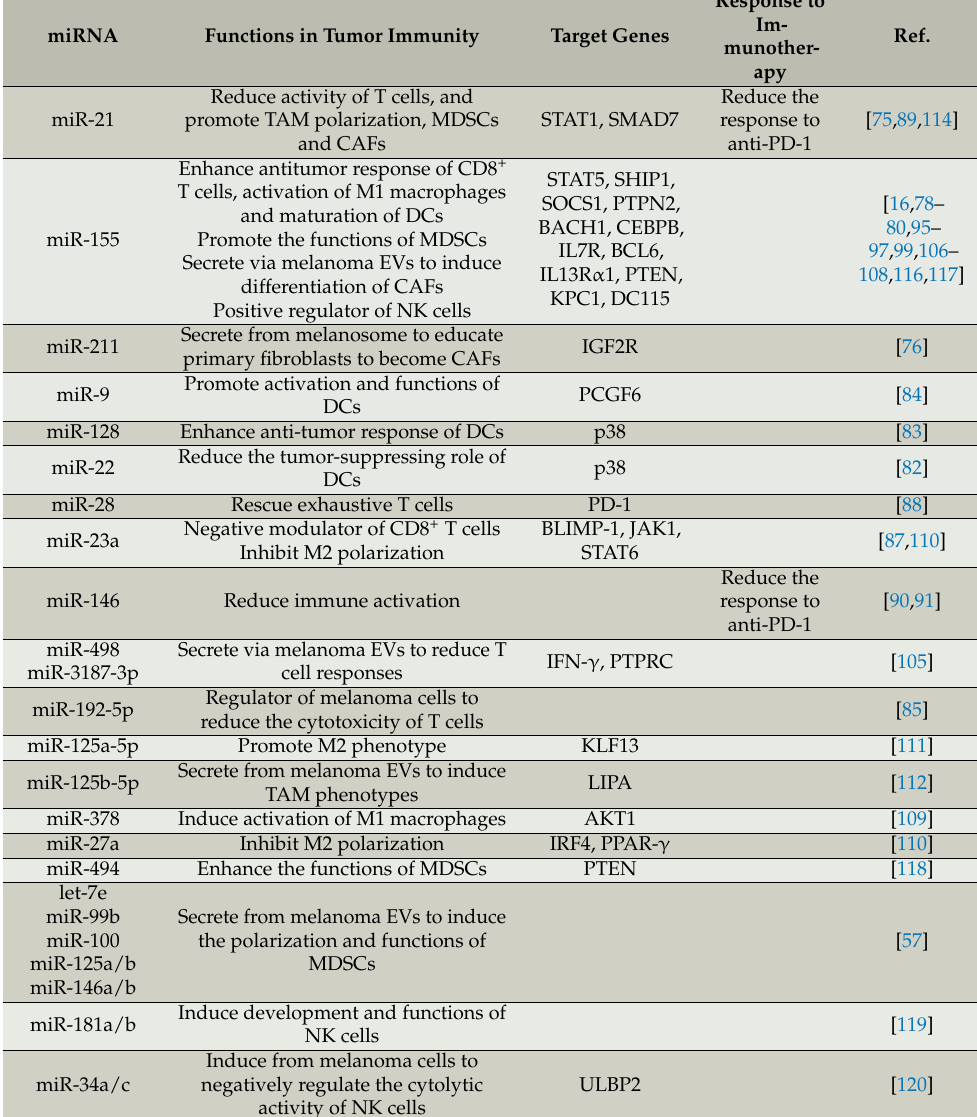
Table 2. miRNAs involved in tumor